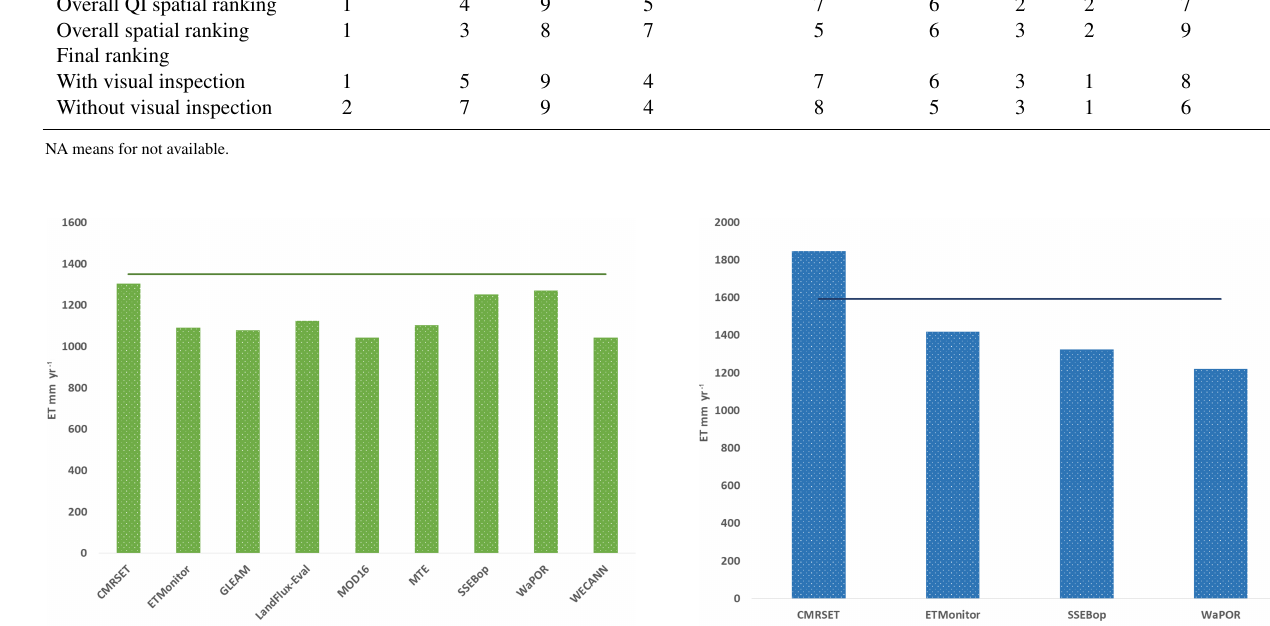
respect to the reference used. The four products that esti- mate ET across water bodies show relatively low biases with the reference PET. CMRSET overestimates ET, whereas ET- Monitor, SSEBop and WaPOR underestimate ET on aver- age across water bodies. The lowest bias for water bodies is found in ETMonitor.